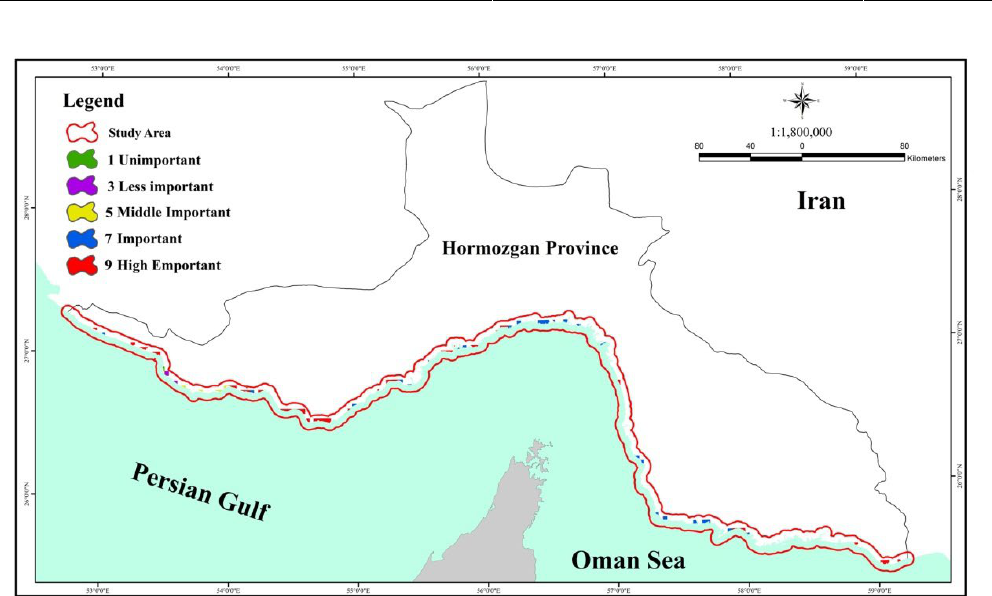
Fig. 9: Final map of site selection for desalination plants